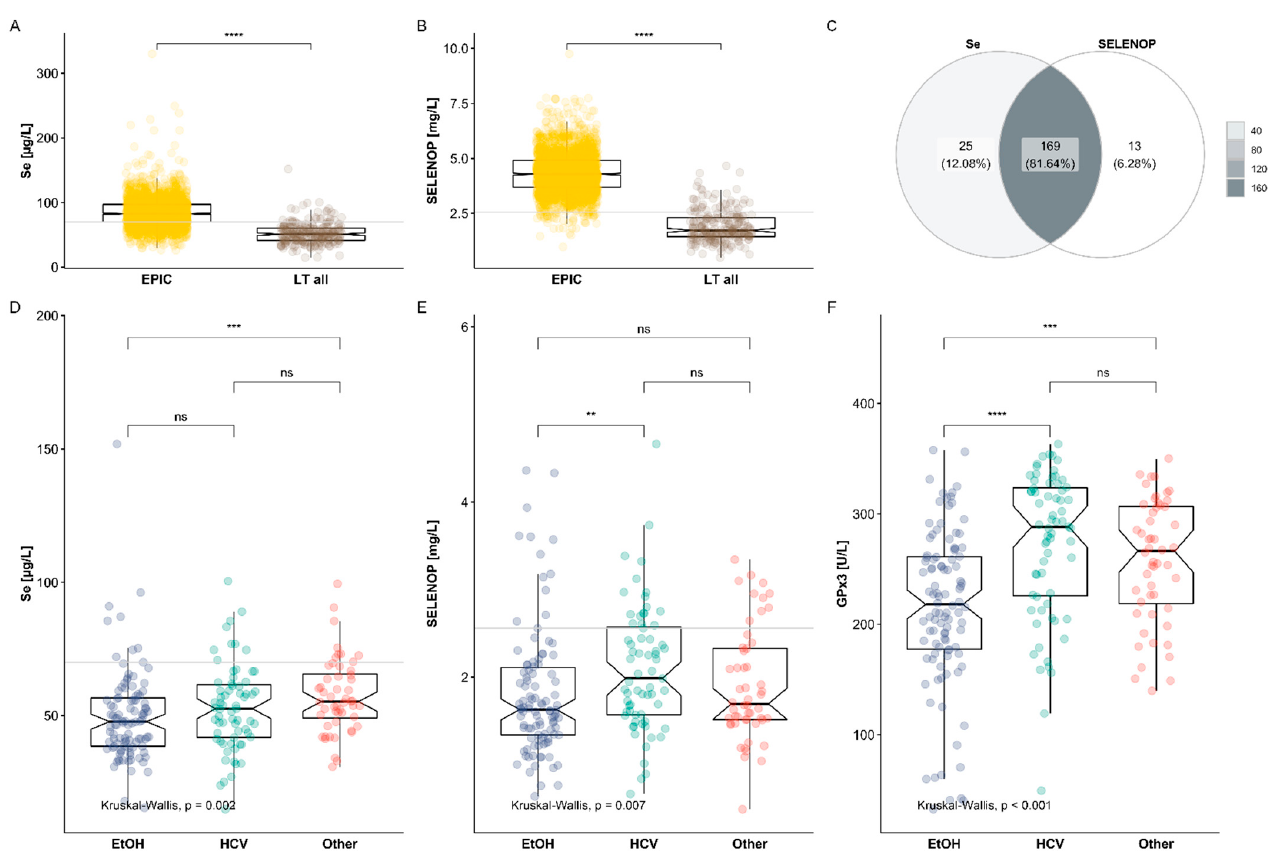
Figure 3. Depressed Se status in patients undergoing liver transplantation (LT). The set of serum samples from patients undergoing LT displayed a general Se deficit, with very low concentrations of ( A ) total Se and ( B ) SELENOP in comparison to a reference cohort of healthy subjects (EPIC). The thresholds for total Se and SELENOP deficiency, i.e., below 70 µg/L and 2.56 mg/L, respectively, are indicated by grey horizontal lines ( A , B , D , E ). In relation to these criteria, ( C ) the majority of patient samples (207/221, 93.7%) displayed a deficit in serum Se or SELENOP, and 81.6% of these presented with a combined deficiency. ( D – F ) The samples were subdivided according to the etiology of hepatocellular carcinoma (HCC) in liver cirrhosis. The largest group represented the patients with cirrhosis due to an ethanol toxicity (EtOH, n = 102, 37 patients), followed by patients with hepatitis C virus cirrhosis (HCV, n = 67, 25 patients) and a group with other etiologies (n = 52, 17 patients). The patients with EtOH-dependent etiology showed relatively low ( D ) total serum Se and ( E ) SELENOP concentrations as well as ( F ) particularly low GPx3 activities. Comparisons by Kruskal–Wallis test; ** p < 0.01, *** p < 0.001 and **** p < 0.0001.